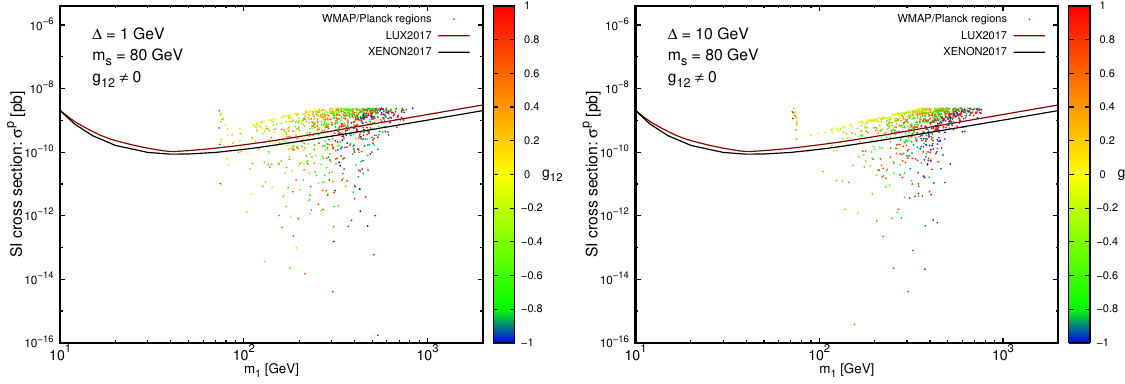
Figure 6 . The DM-proton (SI) scattering cross section as a function of DM mass for the mass splitting (cid:1) = 1 ; 10 GeV, and the singlet scalar mass m s = 80 GeV.